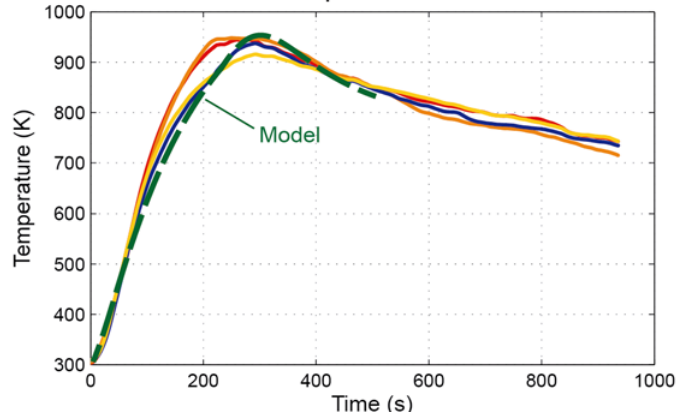
Figure 7. Temporal evolution of the temperatures in the prototype, including the model output ( h slag = 260 W / m 2 K